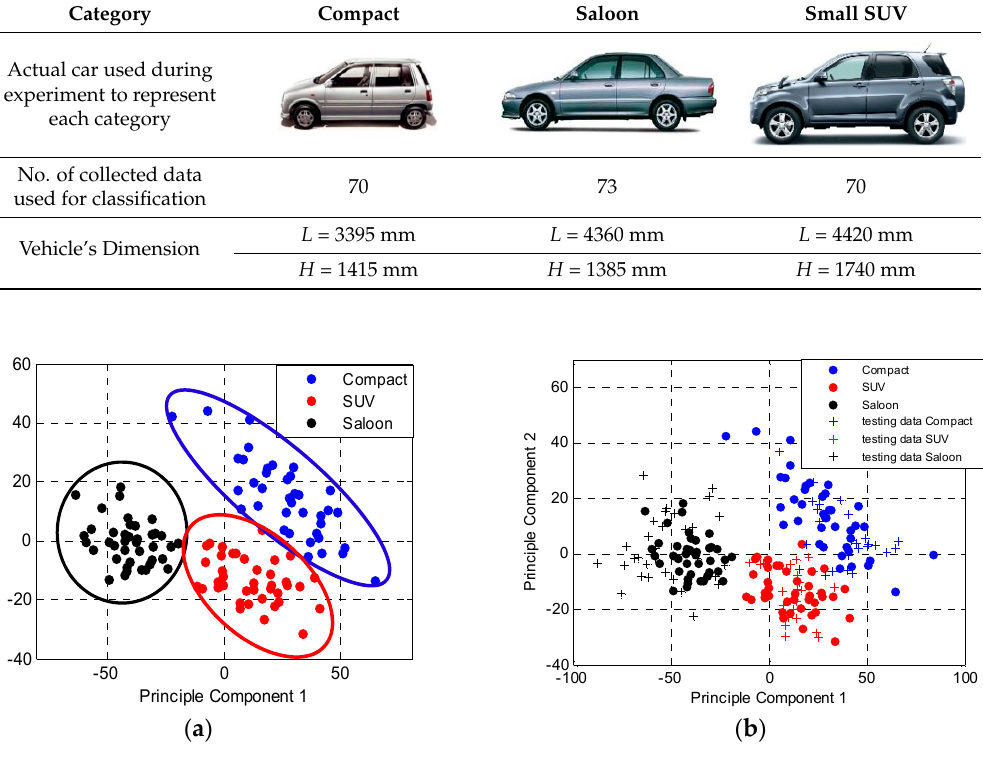
Table 2. Selected vehicle’s detail for each category used for classification system in passive FSR.